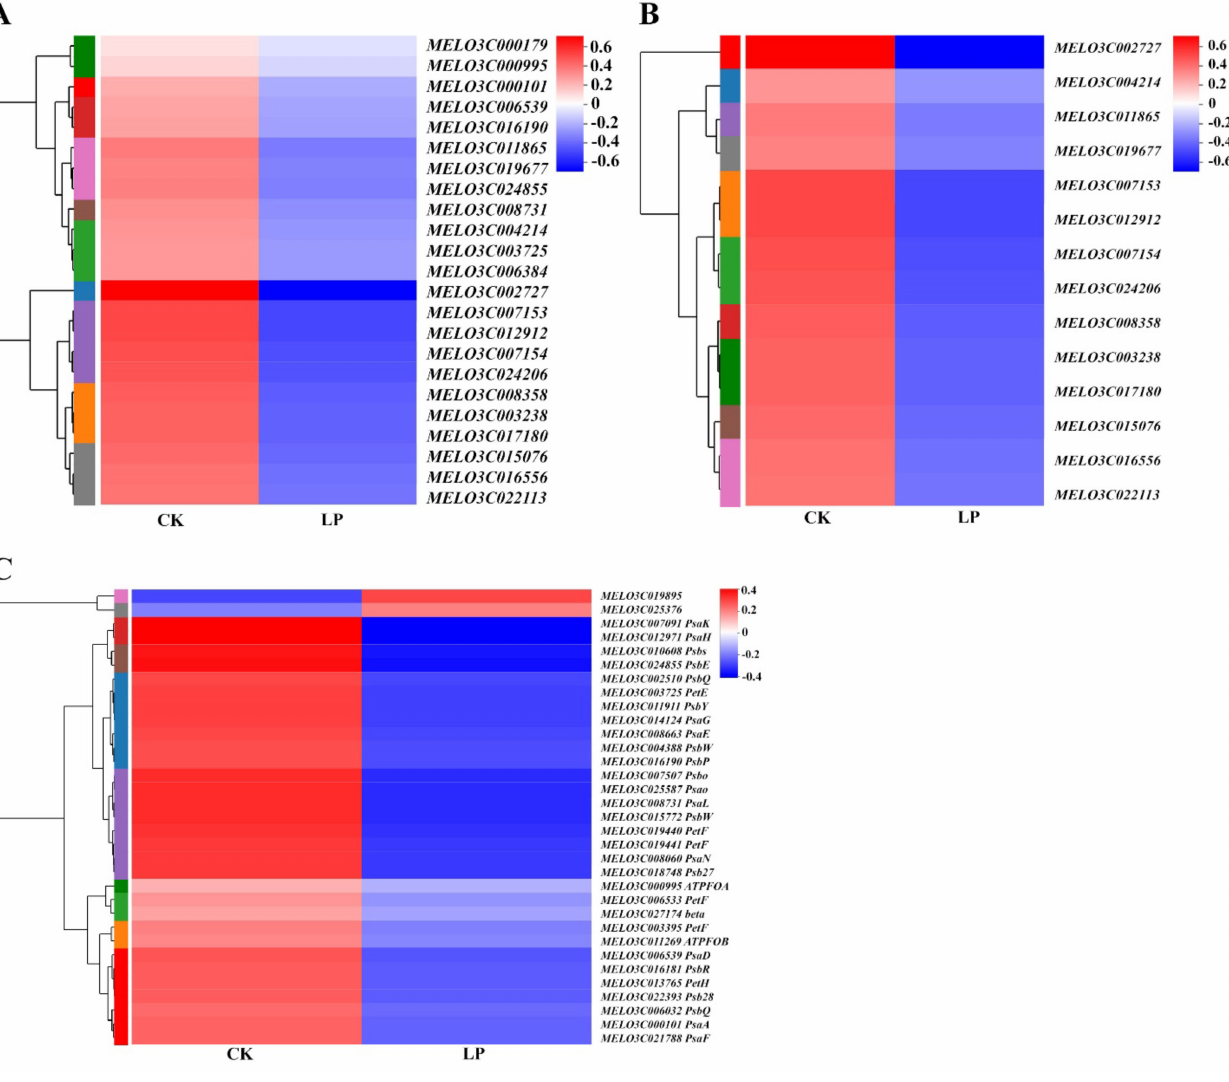
Figure 8. The hierarchical cluster and heatmap of DEGs enriched in the chloroplast thylakoid membrane ( A ), photosynthesis light-harvesting ( B ), and photosynthesis pathway ( C ) based on the log 10 (fold change) values. Genes with a fold change ≥ 2 and an FDR < 0.05 were considered to be DEGs. Blue and red bands were used to represent low and high expression levels,